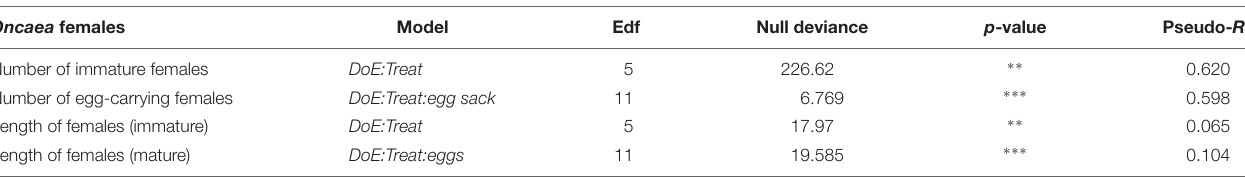
FIGURE 6 | p CO 2 effect on Oncaea spp. females’ development and offspring (N). (A) number of immature females, (B) number of mature females (no egg sack), (C) number of egg-carrying females. Color code: blue = low- p CO 2 (M1, M5, and M9), gray = medium- p CO 2 (M3, M4, and M7), red = high- p CO 2 (M2, M6, and M8). DoE, day of experiment. Solid lines = GLMM predictions ( p -value > 0.05). Dashed area = GLMM predictions confidence interval. TABLE 4 | Oncaea females’